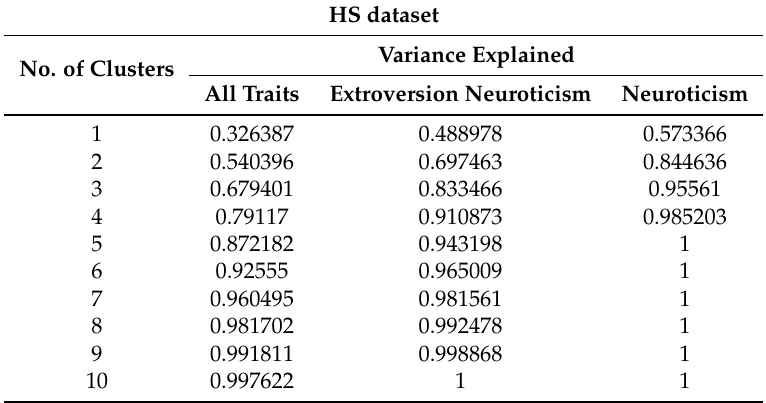
Table 2. Percentage of variance explained in the data based on the number of clusters in the HS data obtained using personality trait